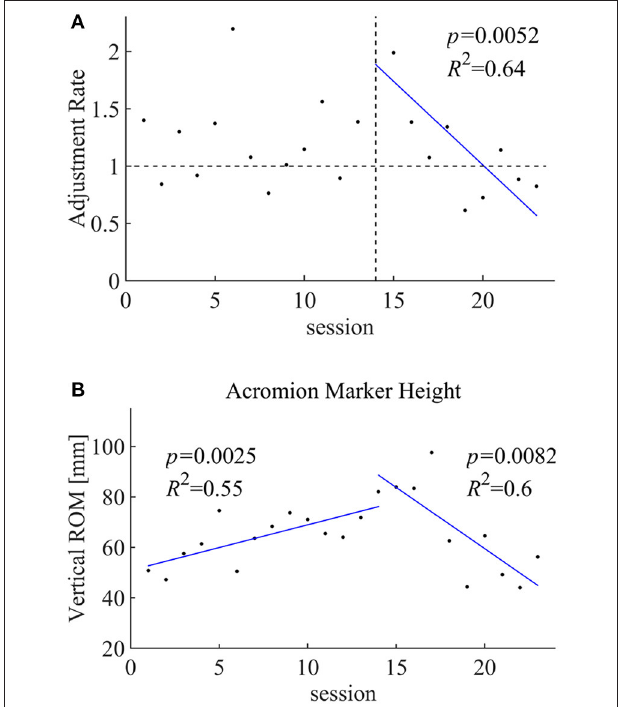
FIGURE 4 | (A) Correlation between the adjustment rate and the shoulder HAL training sessions. (B) Acromion marker height during the shoulder HAL training